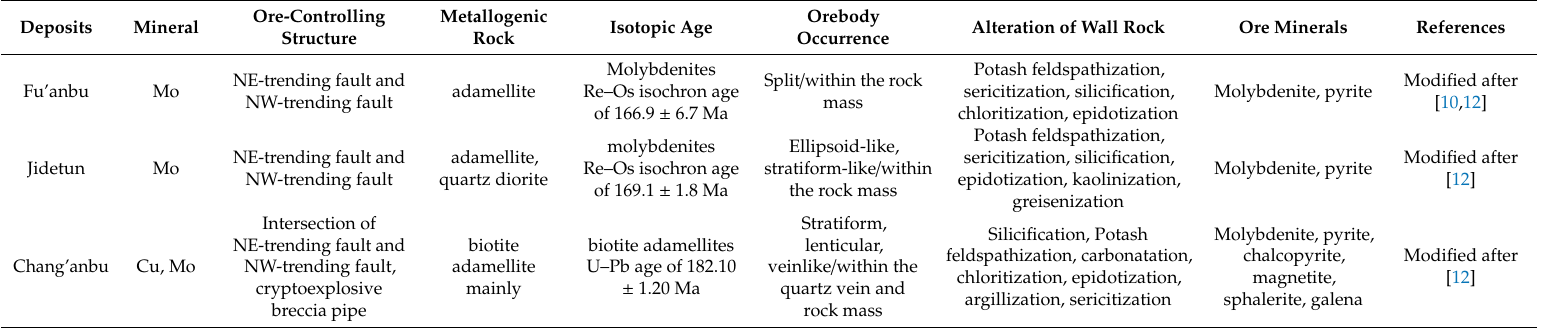
Table 1. Geological characteristics of Mo deposits in the Shulan area (modified after